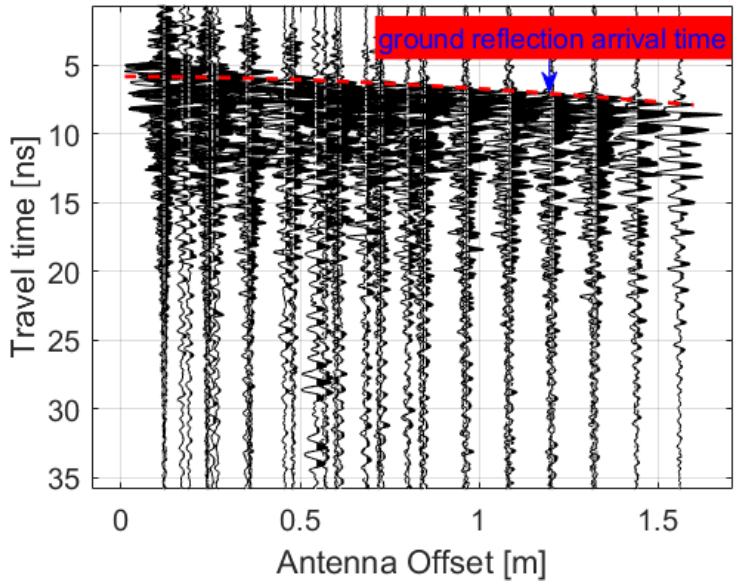
Figure 5. Calculate the antennas height. The dataset is the preprocessed data. The horizontal axis is the antenna offset, whereas the vertical axis is the two-way travel time. The red dotted line is the ground reflection arrival time obtained by Equation